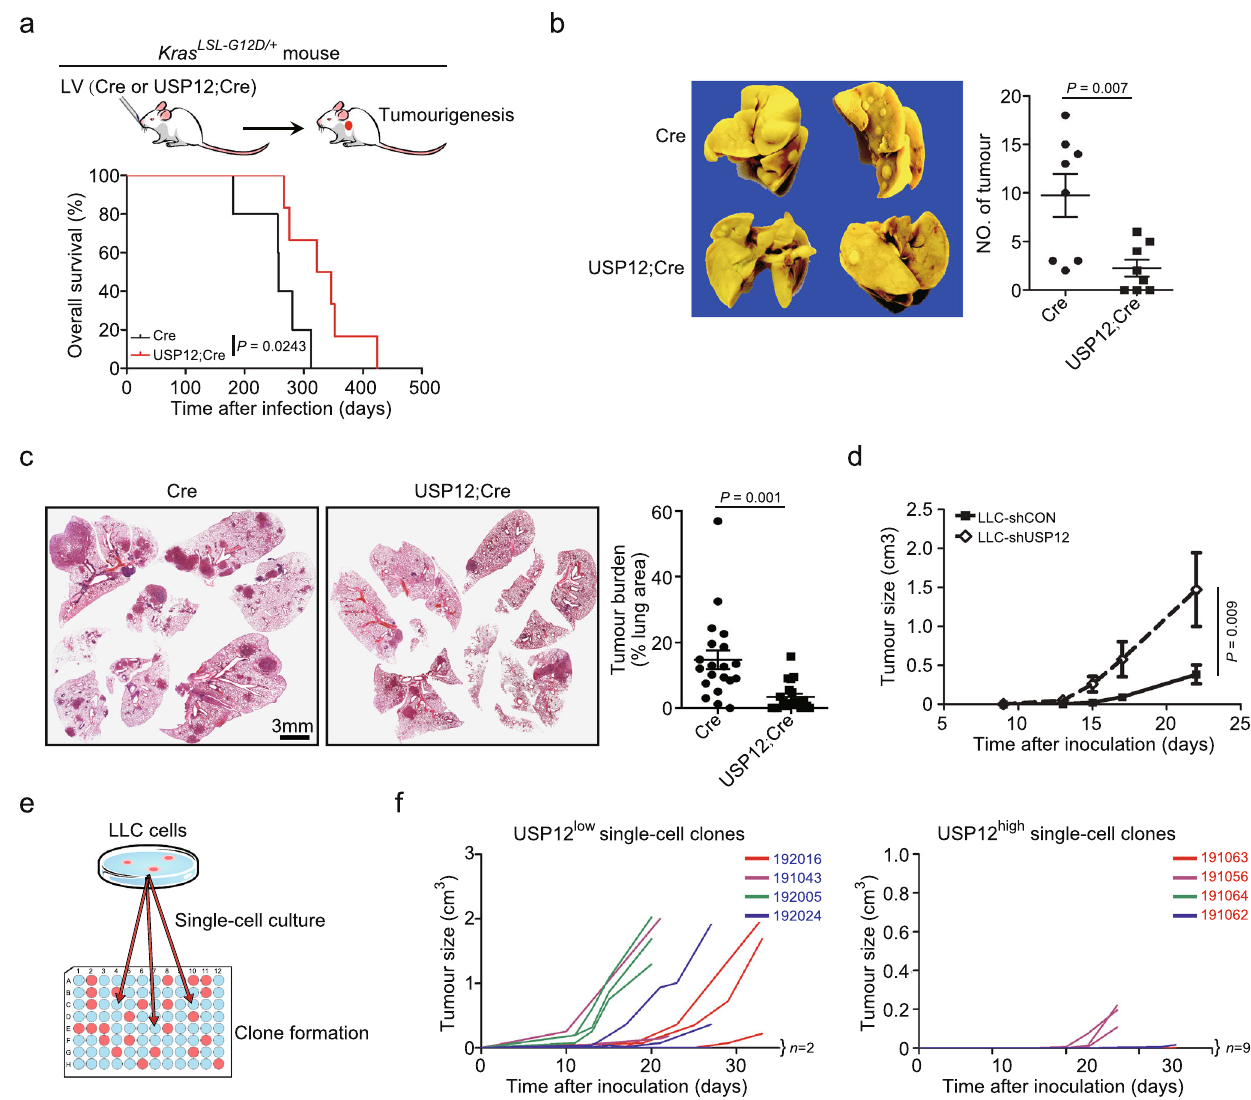
Fig. 2 USP12 negatively regulates lung tumour growth. a Schematic diagram showing the intranasal lentiviral delivery of Cre and USP12 plus Cre (USP12;Cre) in Kras G12D/ + -induced lung tumour (top). LV: lentivirus. Kaplan-Meier plots showing the overall survival of indicated Kras LSL-G12D/ + mice ( n = 5 − 6) (bottom). Two-sided log-rank test. b Representative images of the lungs and statistical analysis of tumour numbers in indicated mouse lungs of Kras LSL-G12D/ + mice 8 months after lentiviral infection (mean±SEM, n = 8 each group). 2-tailed unpaired t -test. c Representative images of H&E-stained lung sections (left) and quantitation of tumour burden in lung lesions described in b (mean±SEM, n = 20 lung lesions each group) (right). 2-tailed unpaired t -test. d Subcutaneous tumour growth of LLC cells stably transduced with control shRNA (LLC-shCON) or shRNA targeting USP12 (LLC-shUSP12) (mean±SEM, n = 5 each group). Two-sided Mann-Whitney U-test to calculate the differences between the tumour sizes of two groups at day 22. e Schematic diagram showing generation of single-cell clones from LLC cells. f Tumour growth kinetics of LLC single-cell clones with low (USP12 low ) or high (USP12 high ) expression of USP12 ( n = 3 − 4 each